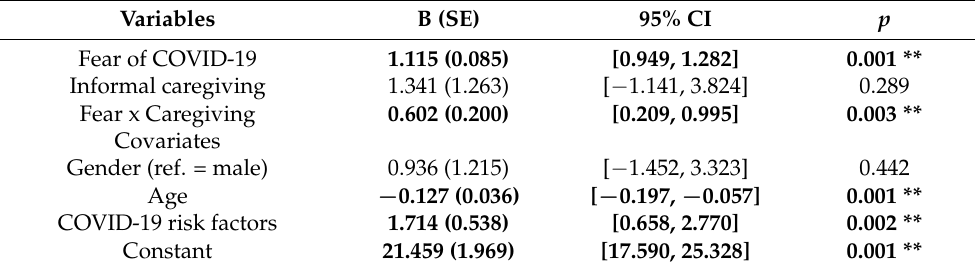
Table 3. Caregiving as a moderator of the relationship between fear of COVID-19 and PTSS symptoms.